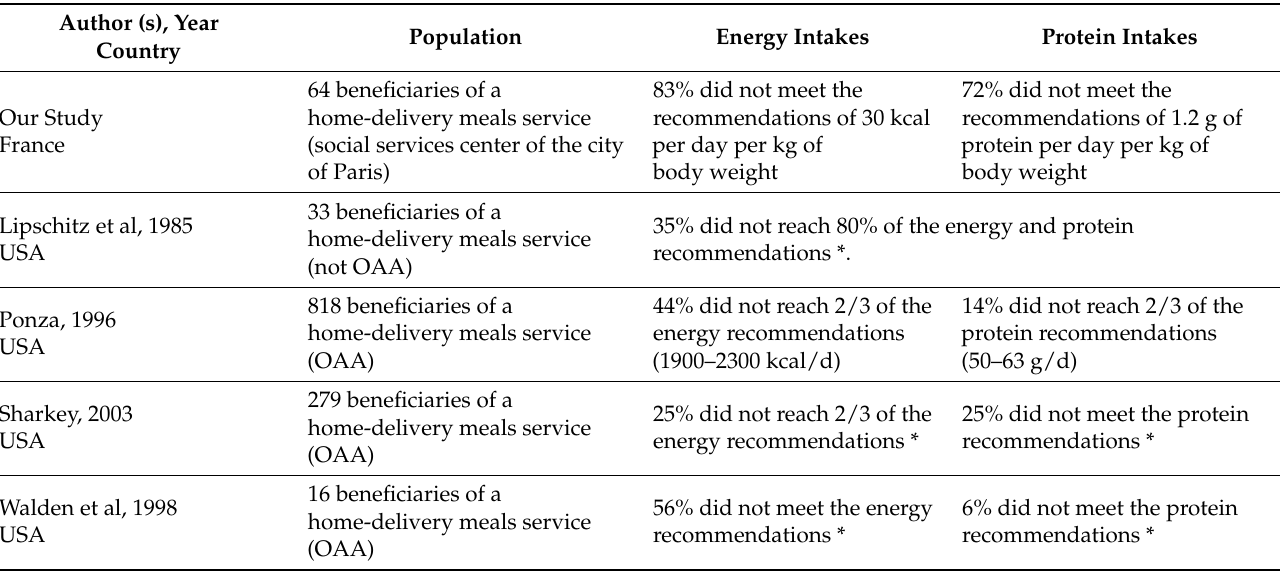
Table 6. The percentage of elderly people benefiting from home-delivery meals service and who do not meet their energy and protein